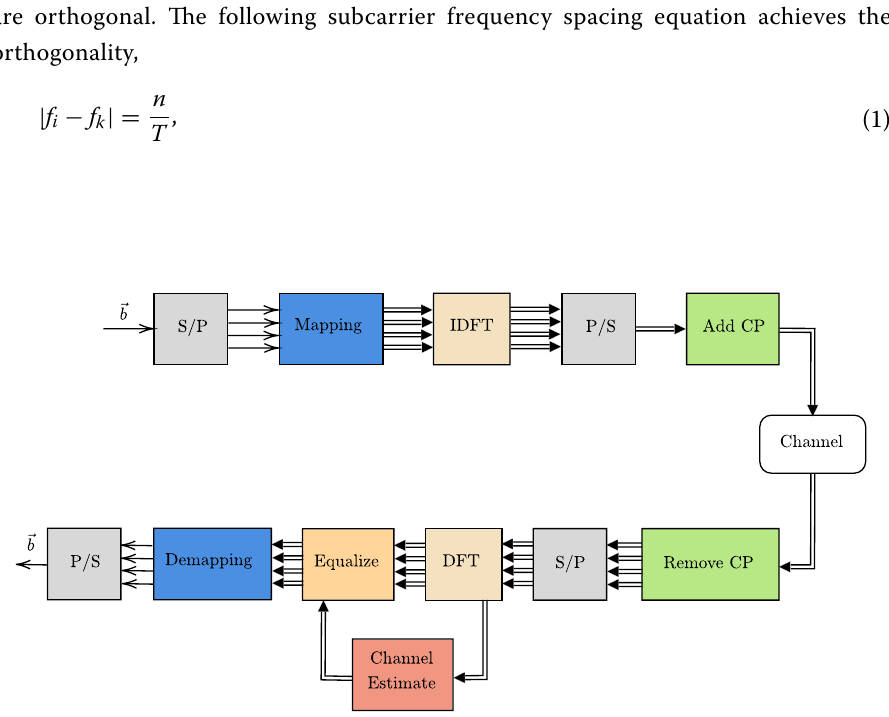
Fig. 2 General OFDM system